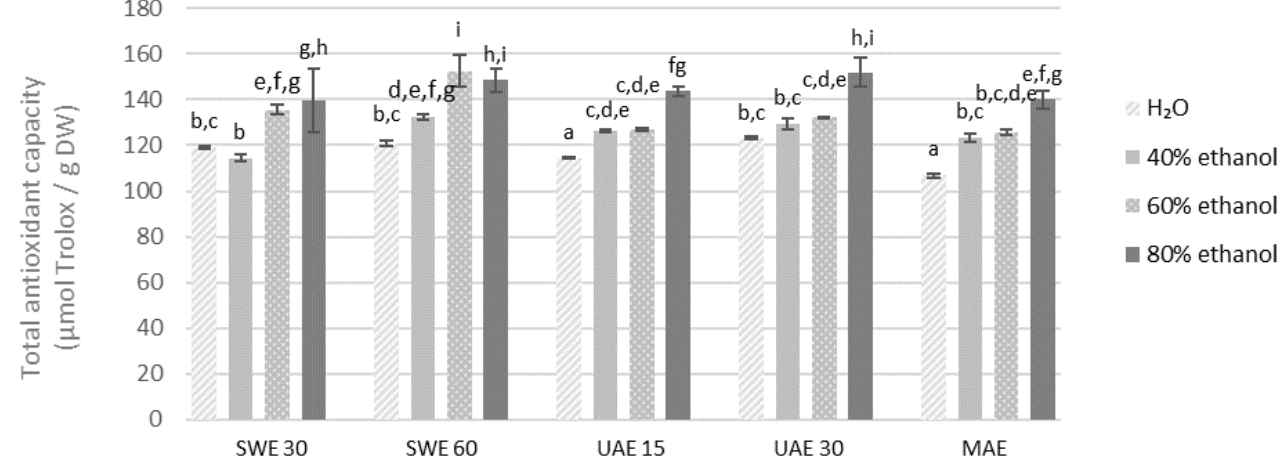
Figure 8. Antioxidant capacity of the extracts obtained from the fraction with particle size 0.5–1.25 mm determined by the FRAP method. SWE—shaking water bath extraction; UAE—ultrasound-assisted extraction; MAE—microwave assisted extraction; 15, 30 or 60-time of extraction. Results are presented as the mean ± SD from triplicate determinations. Different letters: a, b, c, d, e, f, g, h, i indicate that samples are significantly different. The letter “a” marks the lowest value. Higher values are marked with consecutive letters of the alphabet. Bars that share the same letter within the group are not significantly different according to Tukey’s HSD test at p > 0.05.